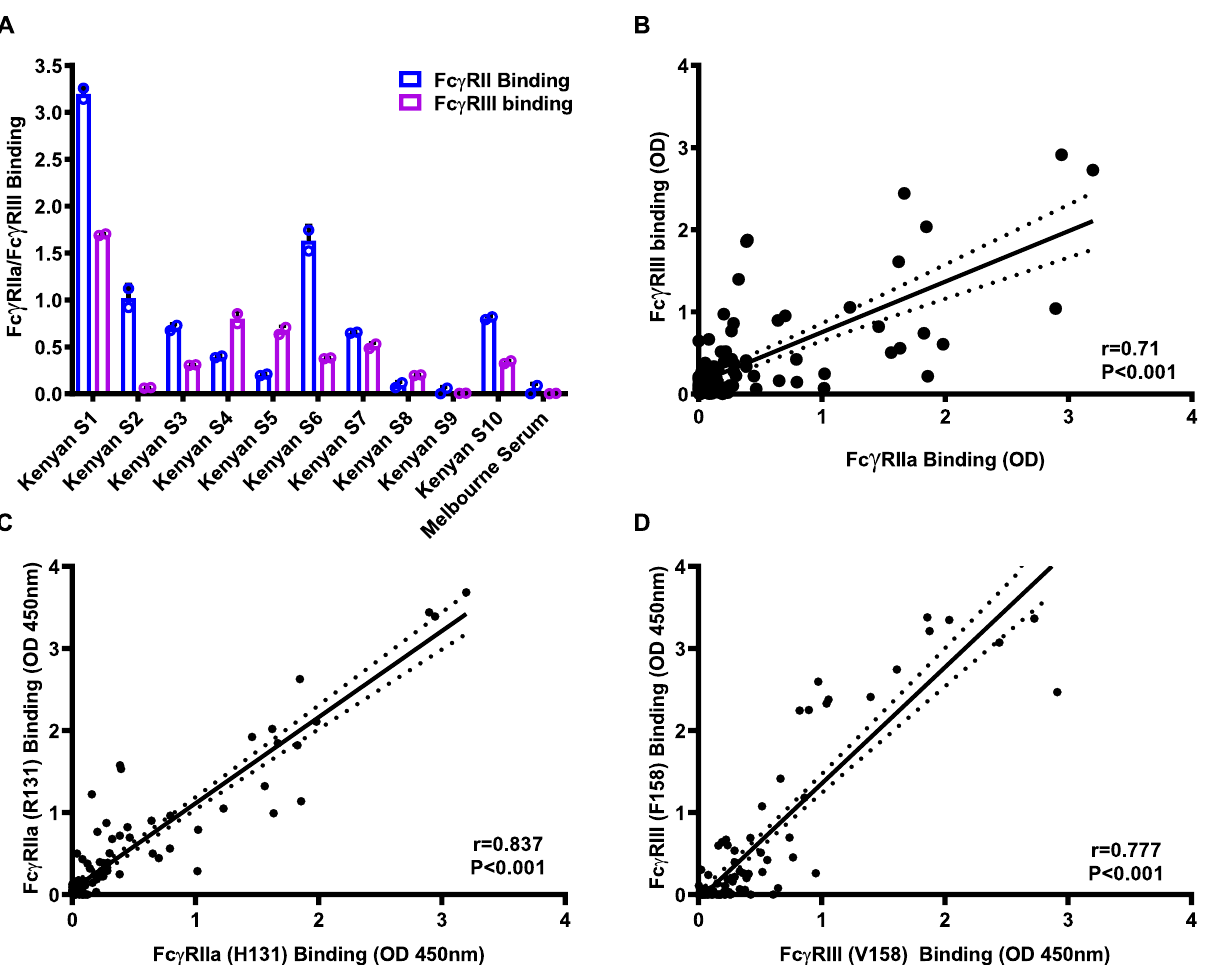
Fig. 3 Direct quanti fi cation of Fc γ RIIa and Fc γ RIII binding activity. A Antibodies to CSP among Kenyan adults were tested for their ability to promote binding to Fc γ RIIa and Fc γ RIII. Bars and error bars represent the mean and standard deviation for each sample tested in duplicate. Representative individuals ( n = 10) are shown to re fl ect the range of activities observed. Sera from malaria-naive Melbourne donors were used as negative controls (MC), which were lower than the Kenyan serum samples (Mann – Whitney test P = 0.026). B Correlation between Fc γ RIIa binding and Fc γ RIII binding in the Kenyan adult cohort. There was a signi fi cant correlation between Fc γ RIIa binding and Fc γ RIII binding ( n = 104, r = 0.71, P < 0.001, linear regression). The solid and dotted lines represent the linear regression line and 95% con fi dence intervals, respectively. C Correlation between antibody-mediated binding of two different alleles of Fc γ RIIa (R131 and H131) using samples from the Kenyan adult cohort ( n = 104, Spearman ’ s rho = 0.837, P < 0.001). The solid and dotted lines represent the linear regression line and 95% con fi dence intervals, respectively. D Correlation between antibody-mediated binding of two different alleles of Fc γ RIII (F158 and V158) using samples from the Kenyan adult cohort ( n = 104, Spearman ’ s rho = 0.777, P < 0.001). The solid and dotted lines represent the linear regression line and 95% con fi dence intervals,